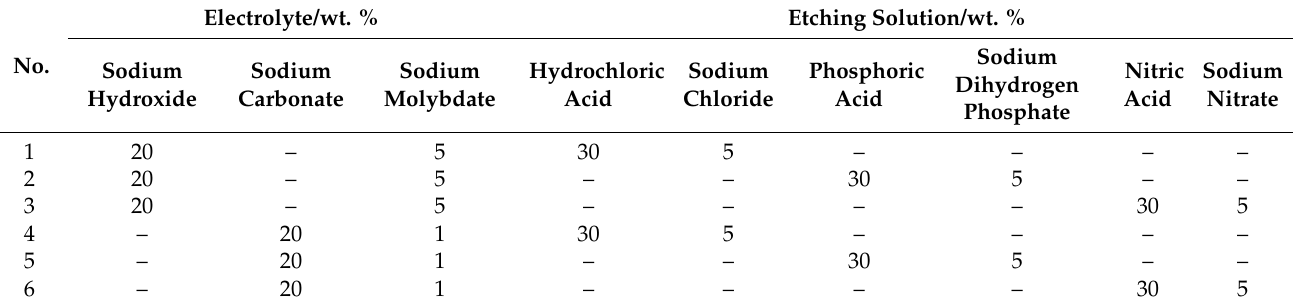
Table 2. Electrolyte and etching solution ratios in each experimental scheme.